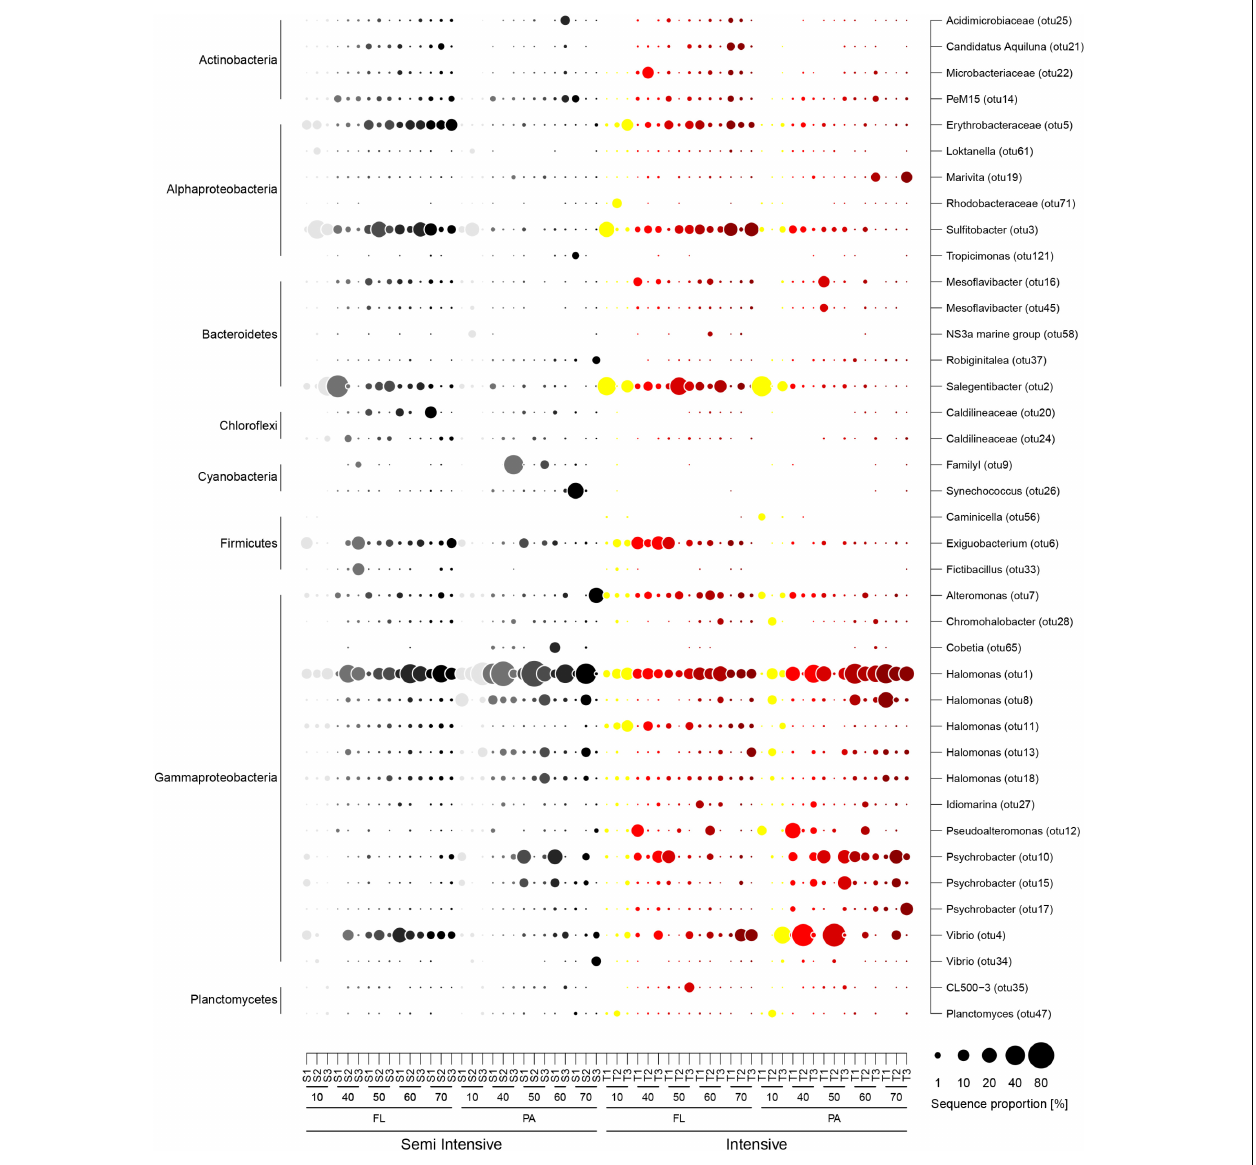
FIGURE 2 | Contribution of the most abundant bacterial operational taxonomic units (OTUs) in the semi-intensive (light gray to black) and the intensive systems (yellow to dark red). Taxonomic affiliation for OTUs is provided for genus (Right) and class (Left) levels. S1–3 and T1–3: replicate pond for the semi-intensive and intensive ponds, respectively. Days of rearing are indicated below the pond symbols. FL, free-living fraction; PA, particle-attached